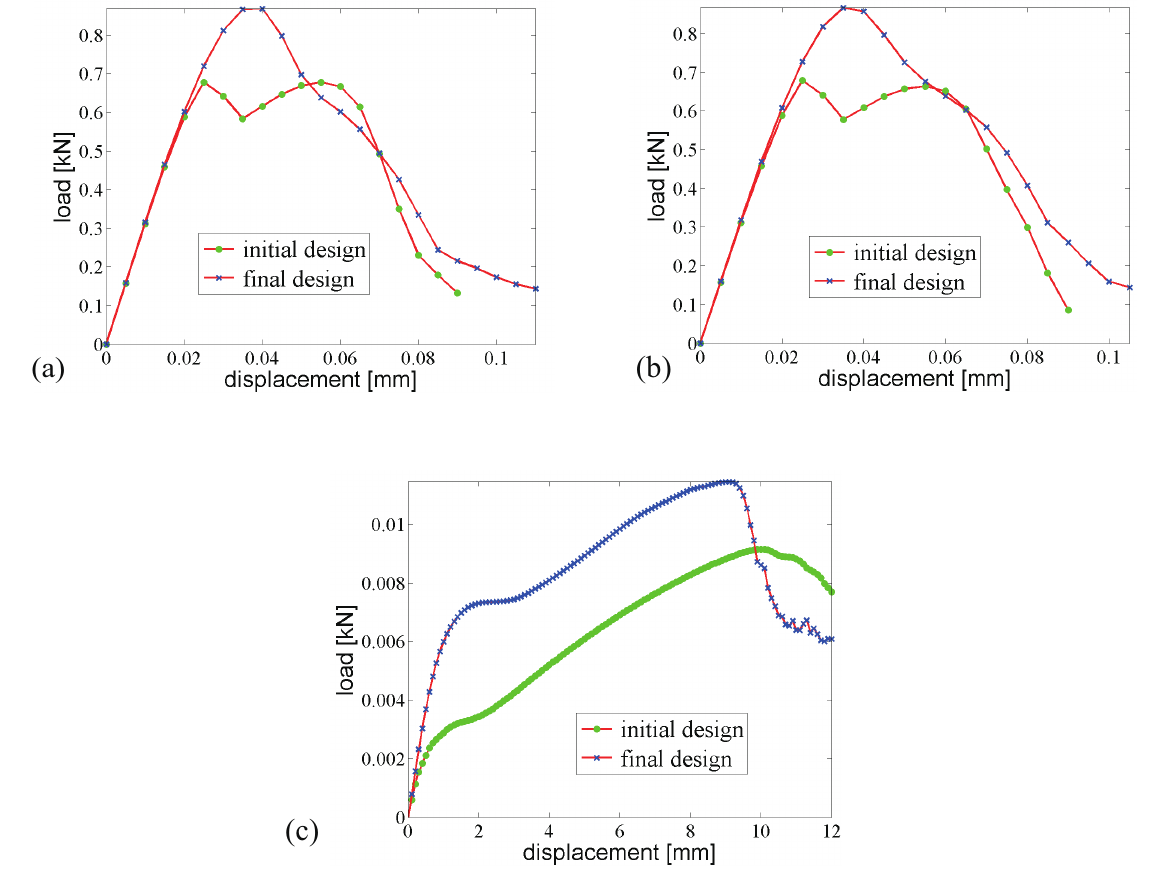
Figure 23. Fracture resistance comparison of two composites with initially randomly distributed inclusions, subjected to ( a ) loading case 1; ( b ) loading case 2; ( c ) loading case